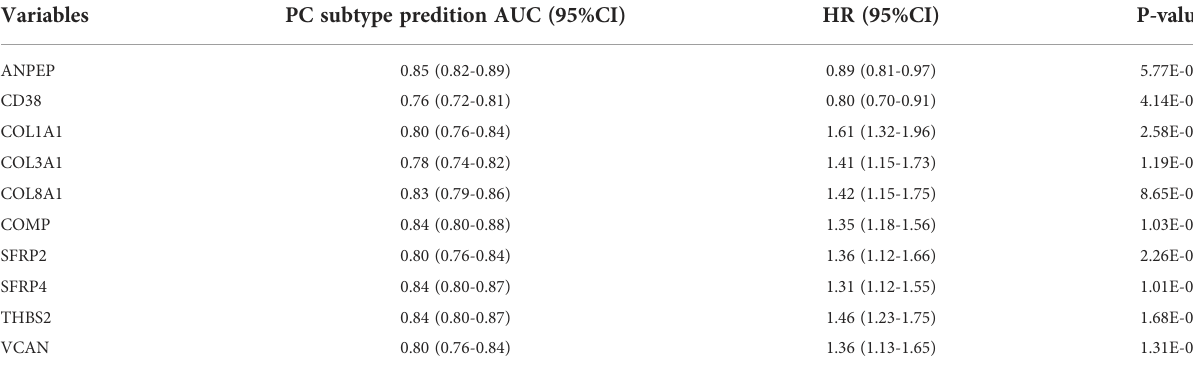
TABLE 2 The 10 gense selected by multiple machine learning algorithms (TCGA